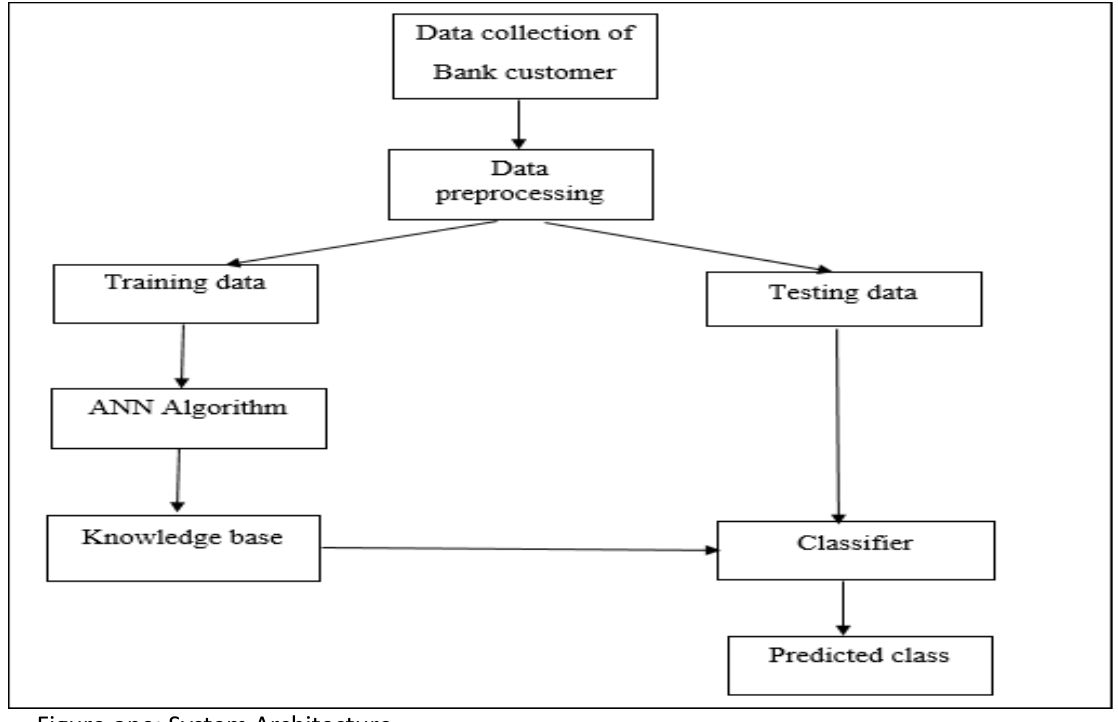
Figure one: System